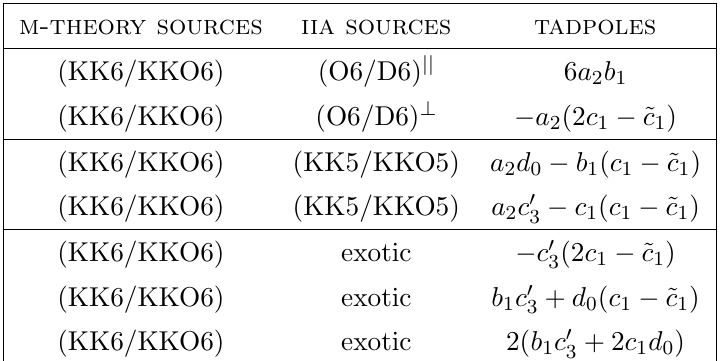
Table 1 . The relation between M-theory (cid:13)uxes and superpotential couplings. One should note that the distinction between the roles of the three di(cid:11)erent moduli S , T and U only becomes relevant when taking the weak coupling limit to type IIA. In this limit, the direction labeled by \7" is singled out, while the other six naturally split into 3+3 (respectively labeled by \ a " & \ m "), which are even (odd) with respect to the orientifold involution enforced by O6 jj planes. The remaining O6 ? planes realize the Z 2 orbifold. 2